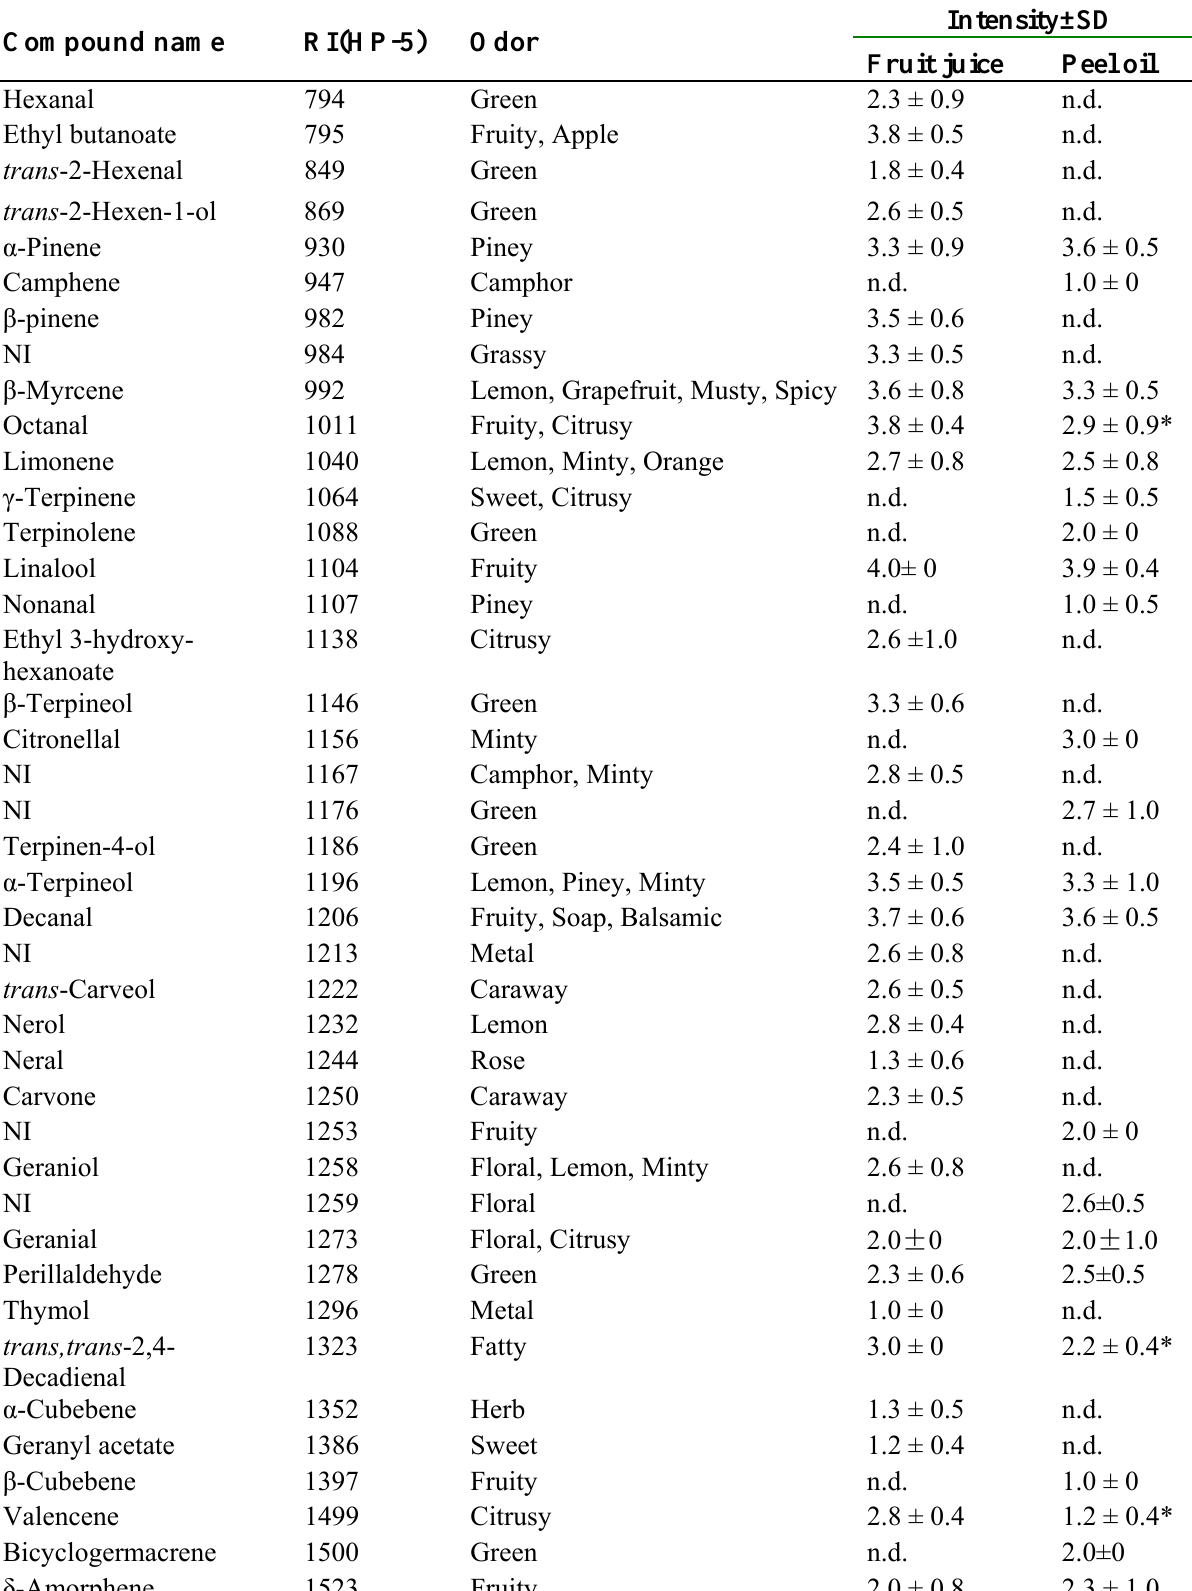
Table 2 . Aroma active compounds of fruit juice and peel oil detected by